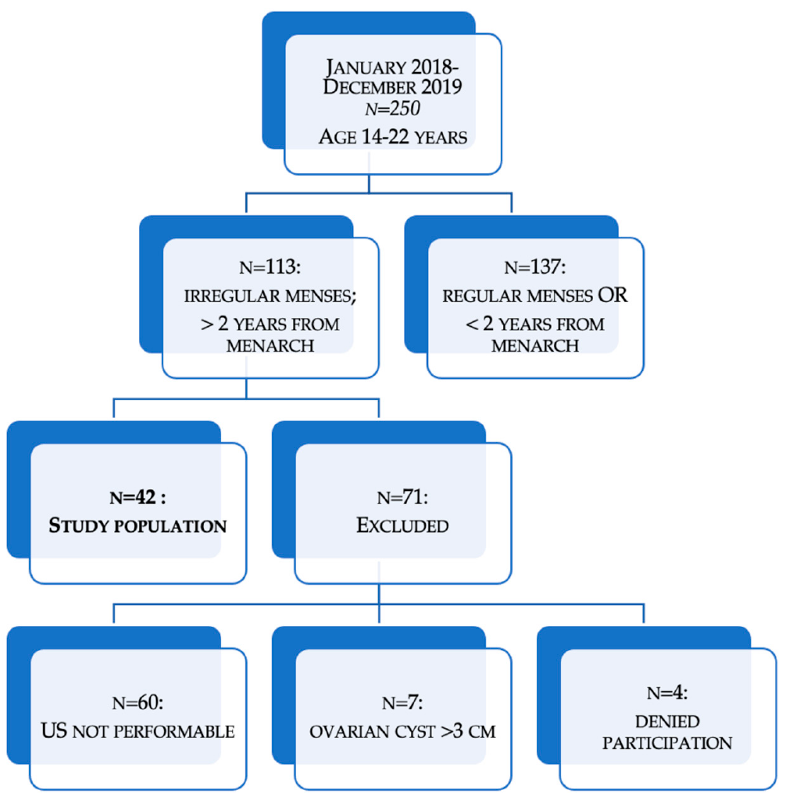
Figure 4. Flow chart of study population selection.